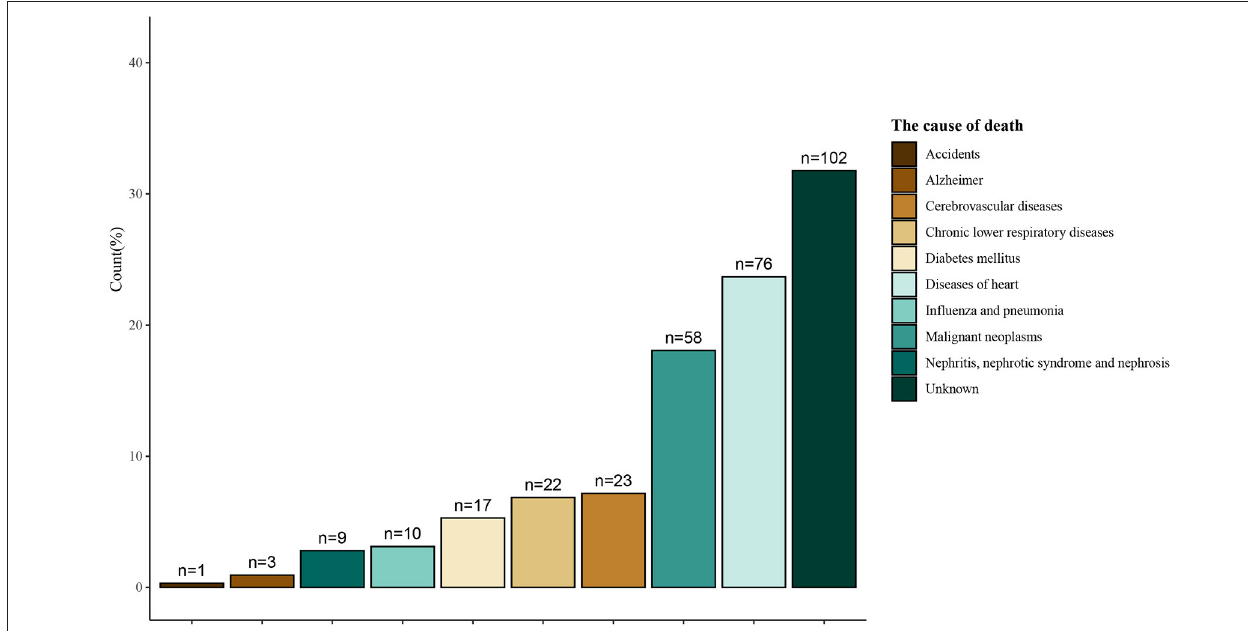
FIGURE 1 | The causes of the all-cause death of CVD patients.